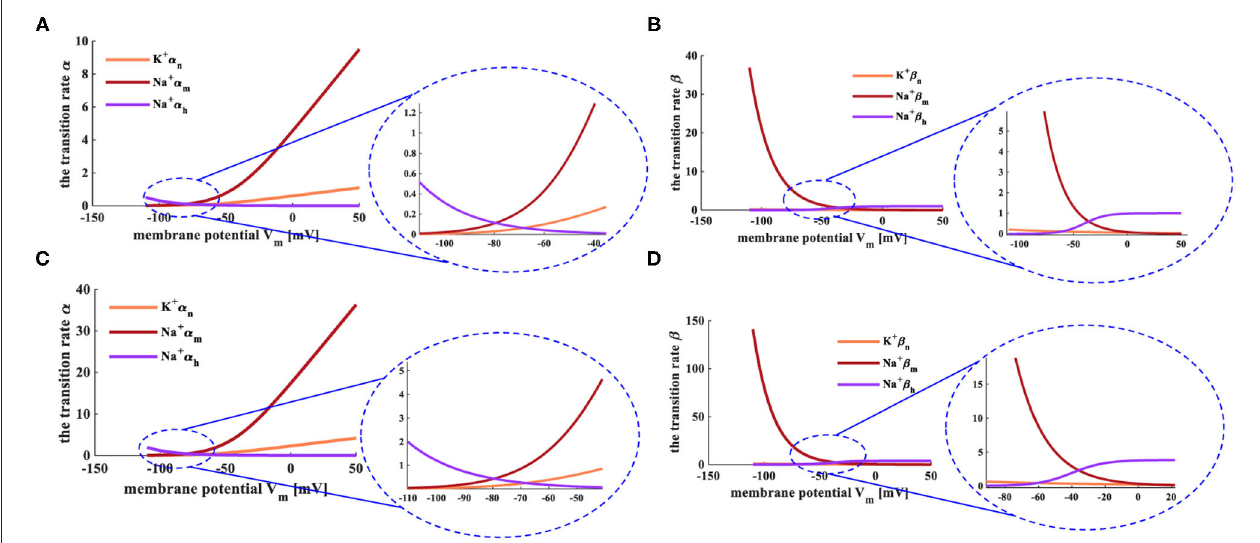
FIGURE 2 | The relationship between transition state and membrane potential. (A) The evolution of the transition rate α at the temperature of 6.3 ◦ C. (B) The variation of the transition rate β at the temperature of 6.3 ◦ C. (C) The evolution of the transition rate α at the temperature of 18.5 ◦ C. (D) The change of the transition rate β at the temperature of 18.5 ◦